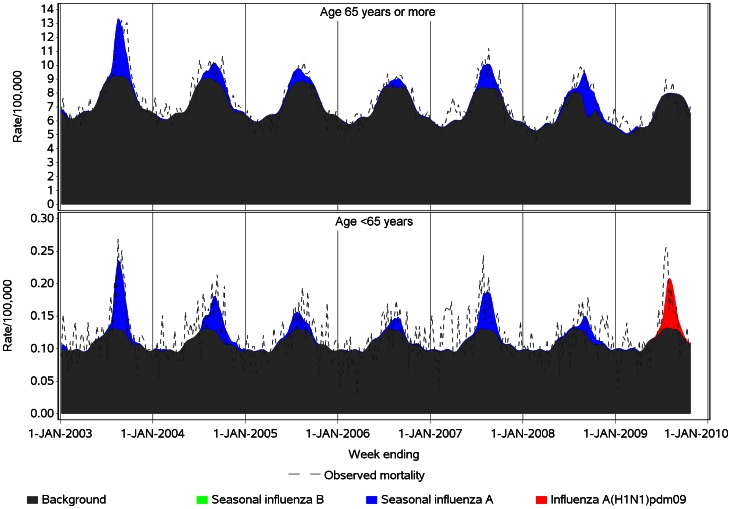
Harmonic model estimates of weekly influenza and non-influenza-attributable respiratory mortality in persons aged <65 and ≥65, by virus type, Australia, 2003 to 2009.Notes: 1. The influenza A laboratory detection time series was included in the regression models as a separate variable for each year, to allow for variation in laboratory reporting and testing methods, virulence of influenza strains and susceptibility of the population (see Table S1 in File S1). 2. For 2009, the seasonal influenza A laboratory detection time series was unable to be included in the regression model for <65 year-olds (see Table S1 in File S1).